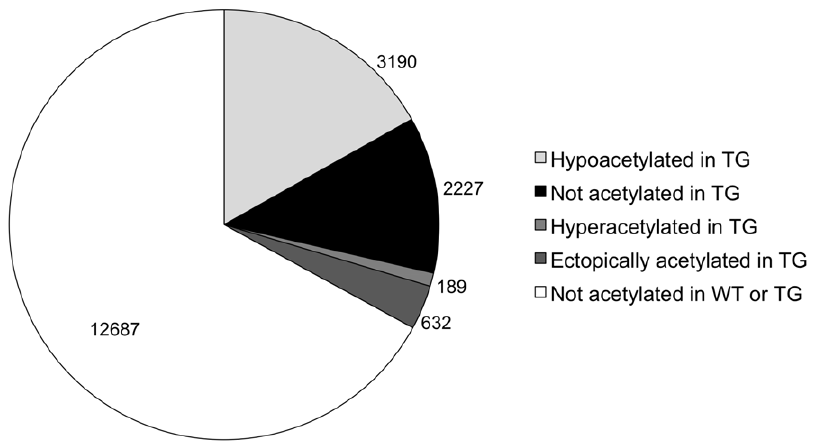
Figure 5. Differential histone H3 acetylation within WT and TG striata. Hypoacetyled in Tg (light grey), gene is bound by AcH3 in both WT and TG but binding is decreased in TG; Not acetylated in TG (black), AcH3 is associated with the gene only in the WT state; Hyperacetylated in TG (medium grey), gene is bound by AcH3 in both WT and TG but binding is increased in TG; Ectopically acetylated in TG (dark grey), AcH3 is associated with the gene only in the TG state; Not acetylated , gene does not have AcH3 associated in either WT or TG states.